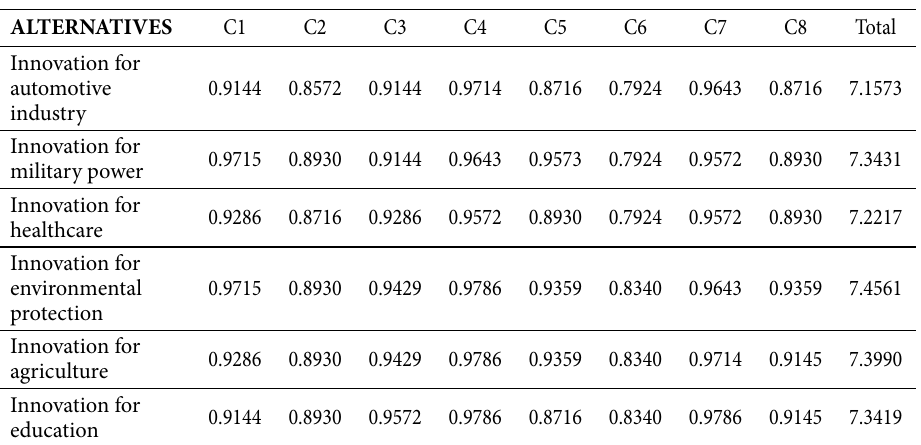
Table 7. Distances to negative ideal solutions